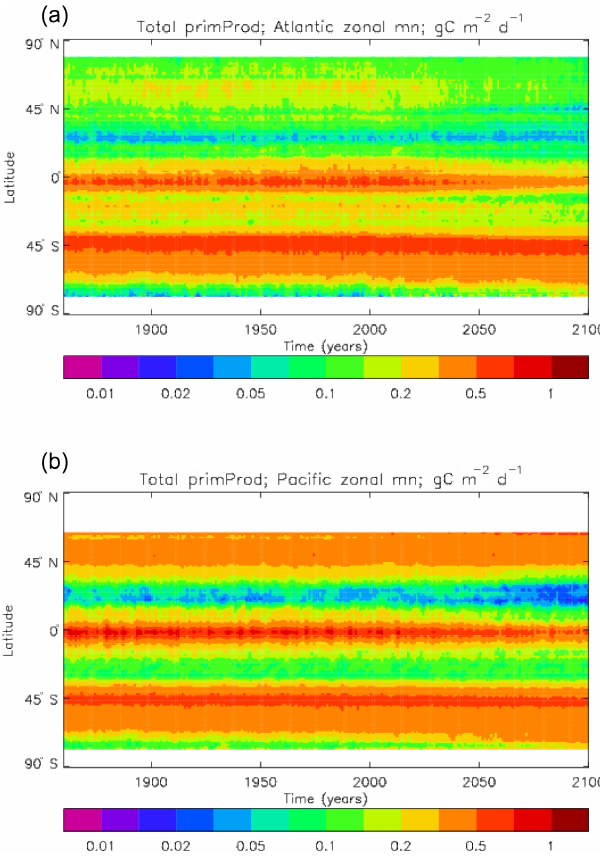
Figure 38. Change in annual mean depth-integrated total primary production (gCm − 2 d − 1 ) during the model years 1860 to 2099 in the CMIP5 historical and RCP8.5 simulations. (a) Atlantic Ocean basin zonal mean; (b) Pacific Ocean basin zonal